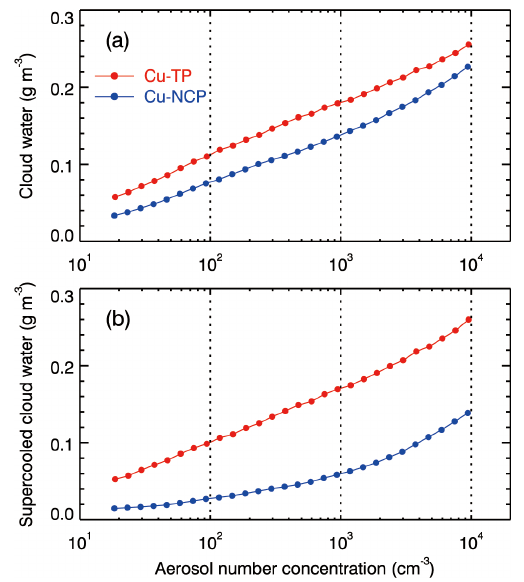
Figure 3. Modeled p mean of (a) cloud water mass concentration and (b) supercooled cloud water mass concentration as a function of the initial [ N a ] in Cu-TP and Cu-NCP in Cu-TP and Cu-NCP.